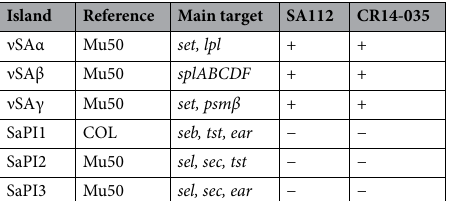
Table 3. Genomic islands detected in the completely closed genomes sequenced in this study obtained from ST5 MRSA strains collected from humans (CR14-035) and canine (SA112). + presence, − absence.